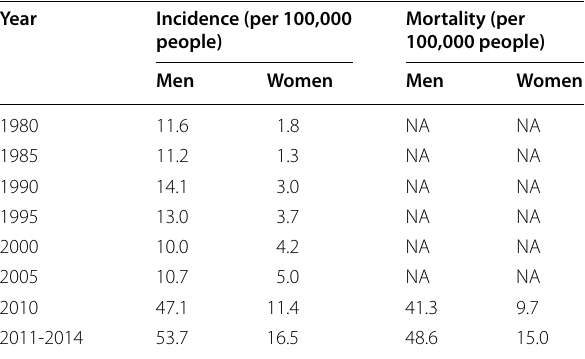
NA Not available Table 6 Age-adjusted rates of lung cancer incidence and mortality in Egypt (2000–2014)